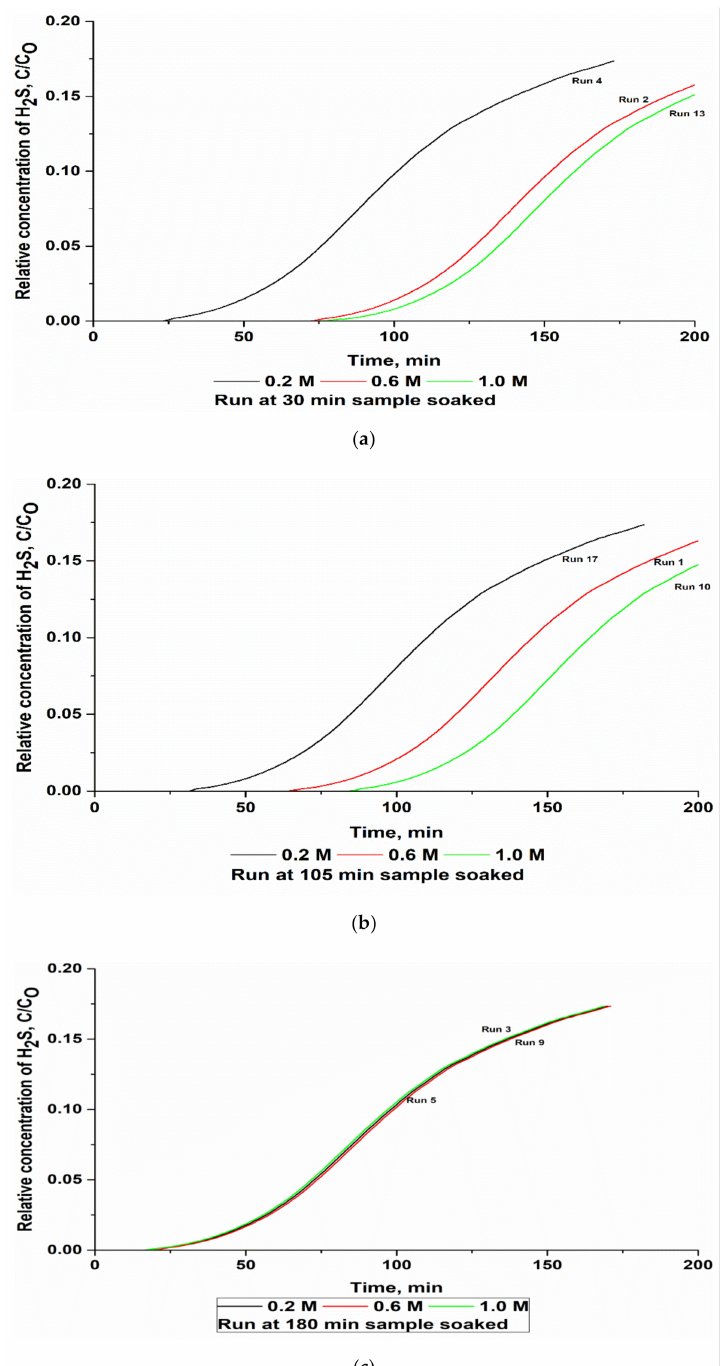
Figure 3. Breakthrough curve of H 2 S versus ZnAc 2 molarity for a constant soaked time: ( a ) 30 min, ( b ) 105 min, and ( c ) 180